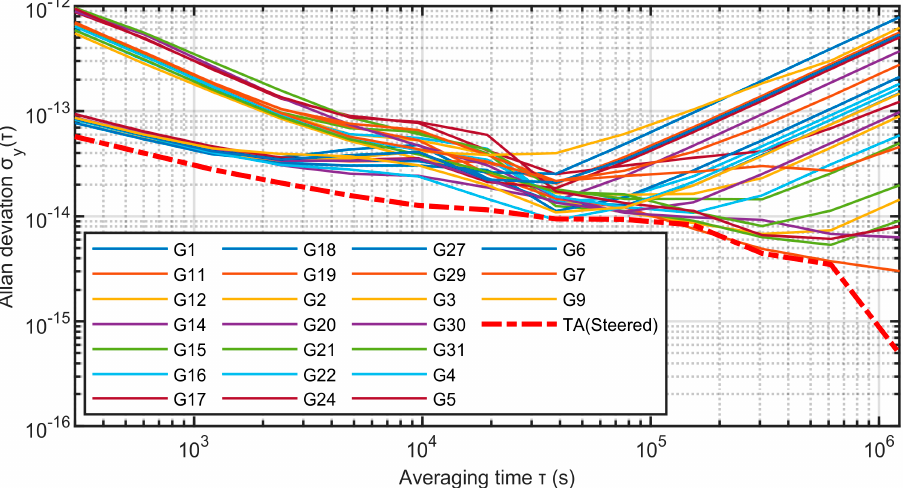
Figure 16. The frequency stability of TA(Steered) and 24 atomic clocks. Table 2. Table of Frequency Stability Statistics.